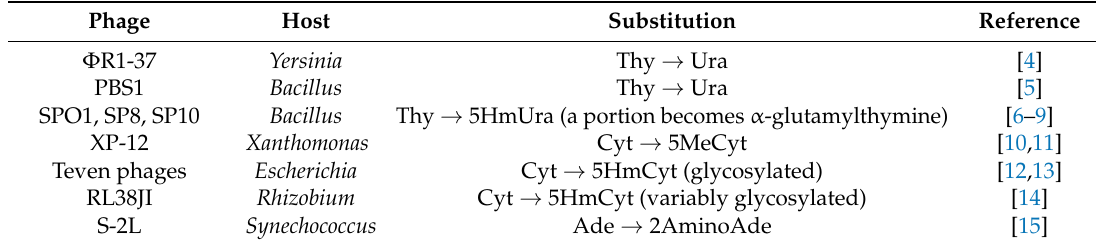
Table 1. Examples of bacteriophages where a canonical base is completely replaced by another base. Phage Host Substitution Reference Φ R1-37 Yersinia Thy → Ura PBS1 Bacillus Thy → Ura SPO1, SP8, SP10 Bacillus XP-12 Xanthomonas Teven